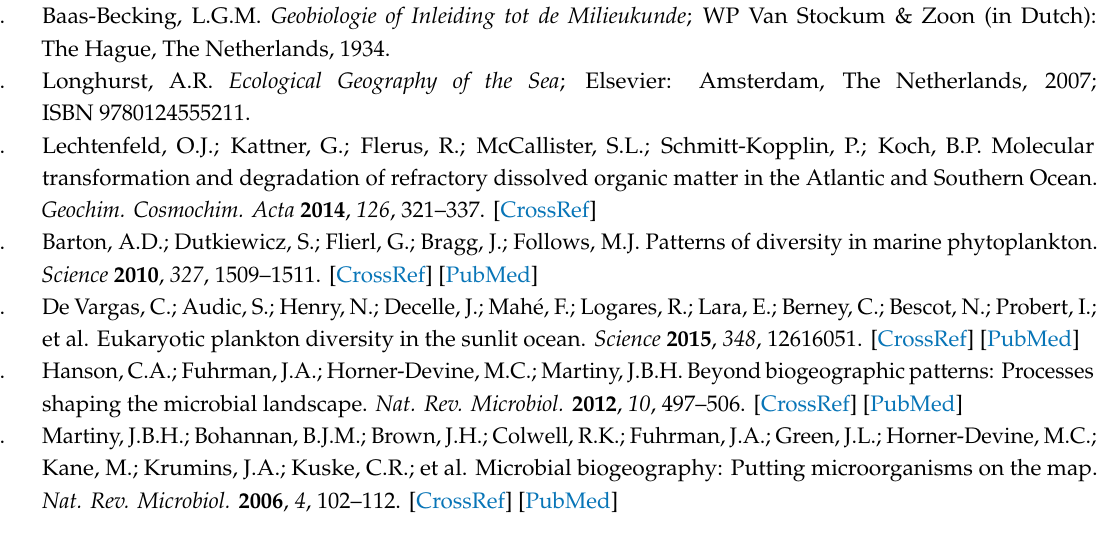
Figure S1: Venn diagram of ASVs among the microeukaryotes in the four coastal sampling regions, Figure S2: Bar chart of the relative rRNA and mRNA diversity of the microeukaryotes, Figure S3: Distribution of taxonomic groups in the four coastal sampling regions, Figure S4: Principle Component analysis (PCA) of Euclidean distances of environmental parameters, Figure S5: Distribution of environmental parameters of the sampling regions, Figure S6: FuncTree2 Plots of all Pfam domains corresponding to KEGG Orthologies (KO) terms for each region, Figure S7: Heat map of correlation between environmental parameters and relative abundance of dinoflagellates and diatoms, Figure S8: FuncTree 2 Plot of correlations with Pfam domains and what the variability is most likely related to, including chlorophyll-a, phosphate, and silicate, Figure S9: The negative correlation between dinoflagellates and diatom Pfam abundancetitle, Table S1: Overview of 454-pyrosequencing reads and number of ASVs, Table S2: Details to supplementary Figure S5: Environmental parameters